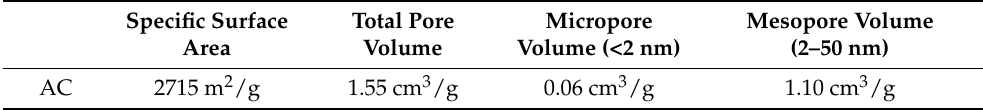
Table 1. Characteristics of the petroleum coke-based activated